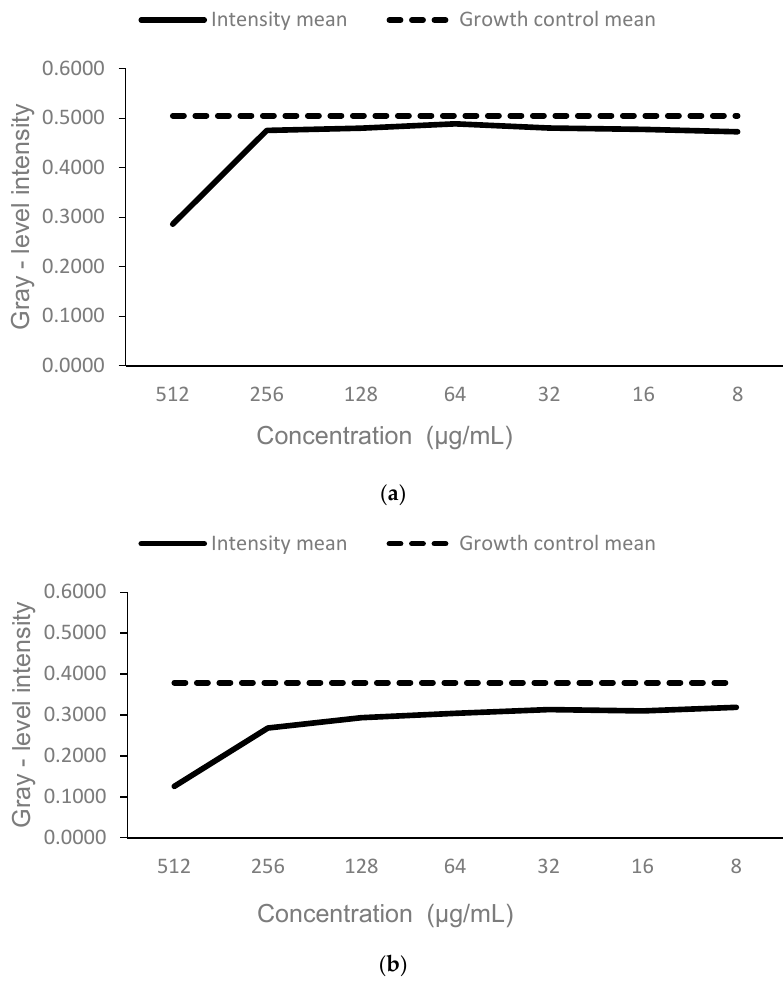
Figure 3. ( a )—Graph representing the growth inhibition curve (GIC) and the maximum growth of the 1199 strain before the addition of resazurin. ( b )—Graph representing the growth inhibition curve (GIC) and the maximum growth of the 1199 strain after the addition of resazurin. Table 1. The 1199 strain—Gray levels intensity before the addition of